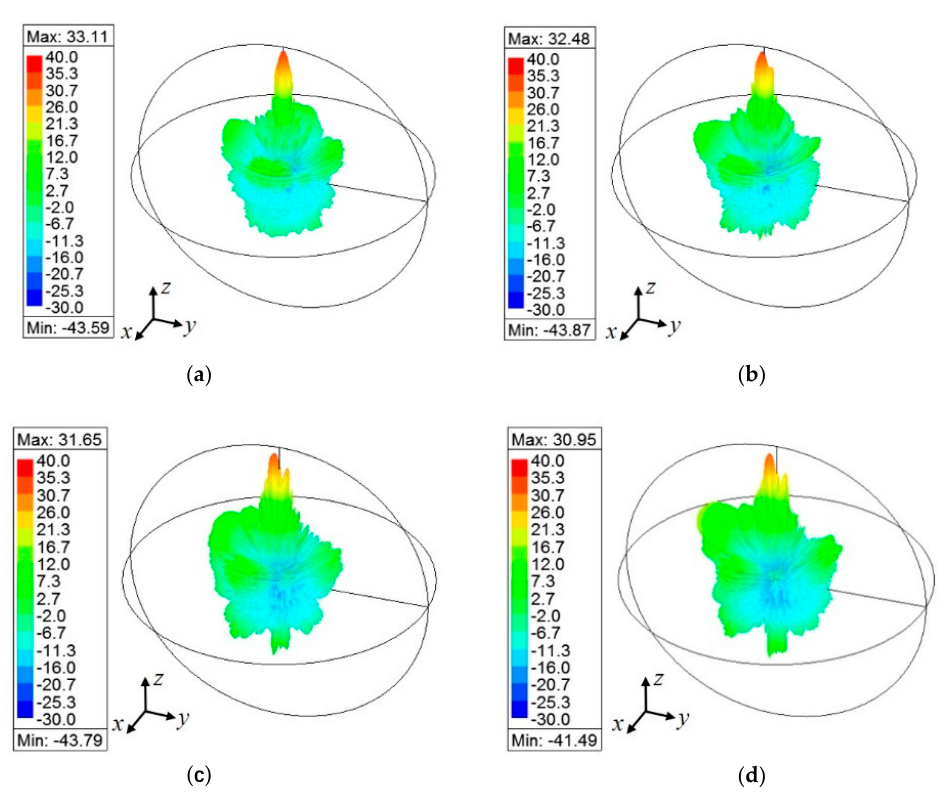
Figure 14. Simulated 3D radiation patterns for the input phase offset of ( a ) 0°, ( b ) 45°, ( c ) 90°, and ( d ) 135°, along y -axis for lens applied to 4 × 4 antenna array.